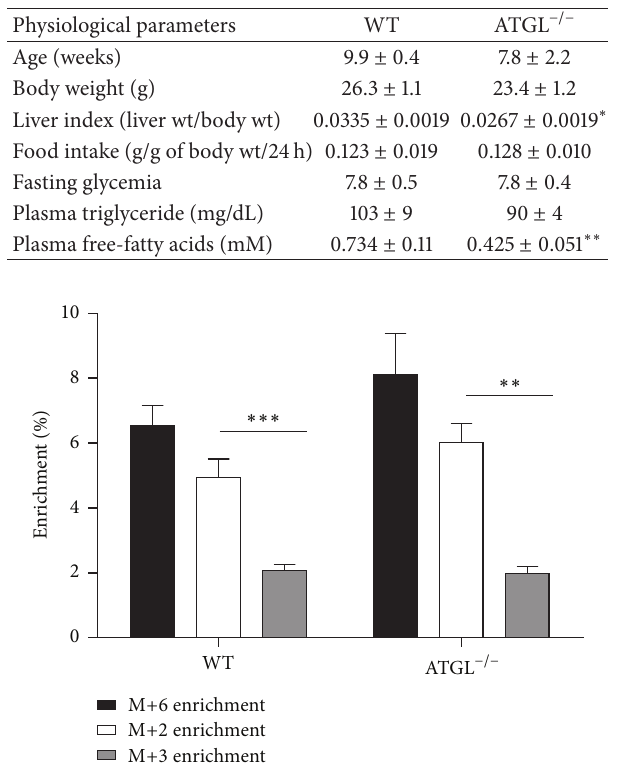
Table 1: Physiological characteristics for WT and ATGL −/− mice.